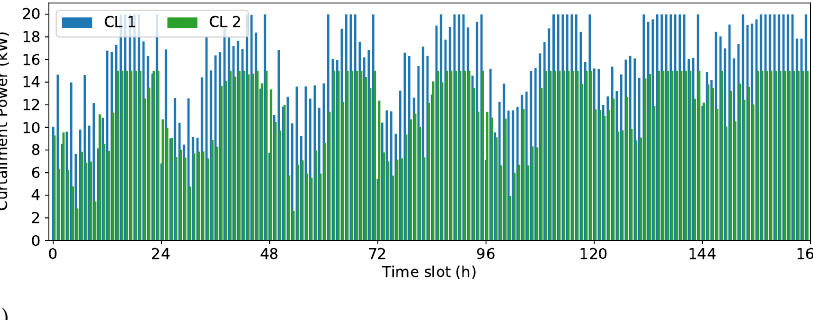
Figure 8. Online scheduling decisions made by the proposed algorithm on seven consecutive test days. ( a ) Hourly electricity prices and net load; ( b ) Charging-discharging power and SOC pattern of the battery; ( c ) Power output of the DGs and the power exchange between the microgrid and utility grid; ( d ) Power curtailment of controllable